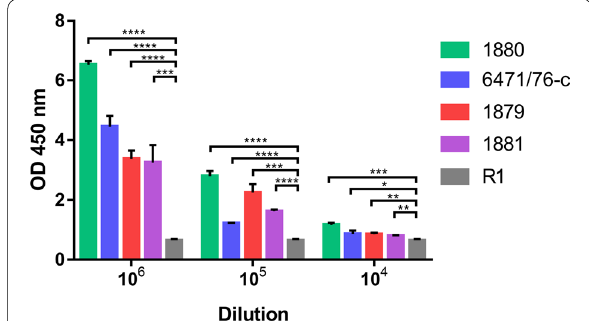
Fig. 3 The sensitivity the H/MTFP‑Gp17—based ELISA for specific detection of YeO:3 bacteria. The wells were coated with YeO:3 bacteria at indicated concentrations. For the detection H/MTFP‑Gp17 at 8.5 µg/ml was used, and the bound H/MTFP‑Gp17 was detected as described in Fig. 4 legend. As the negative control R1 strain was used. SD was calculated from 3 replicates. T‑test was performed between tested strains and control strain R1 (*‑ P 0.05; **‑ P 0.01; ≤ ≤ ***‑ P 0.001; ****‑ P ≤ ≤